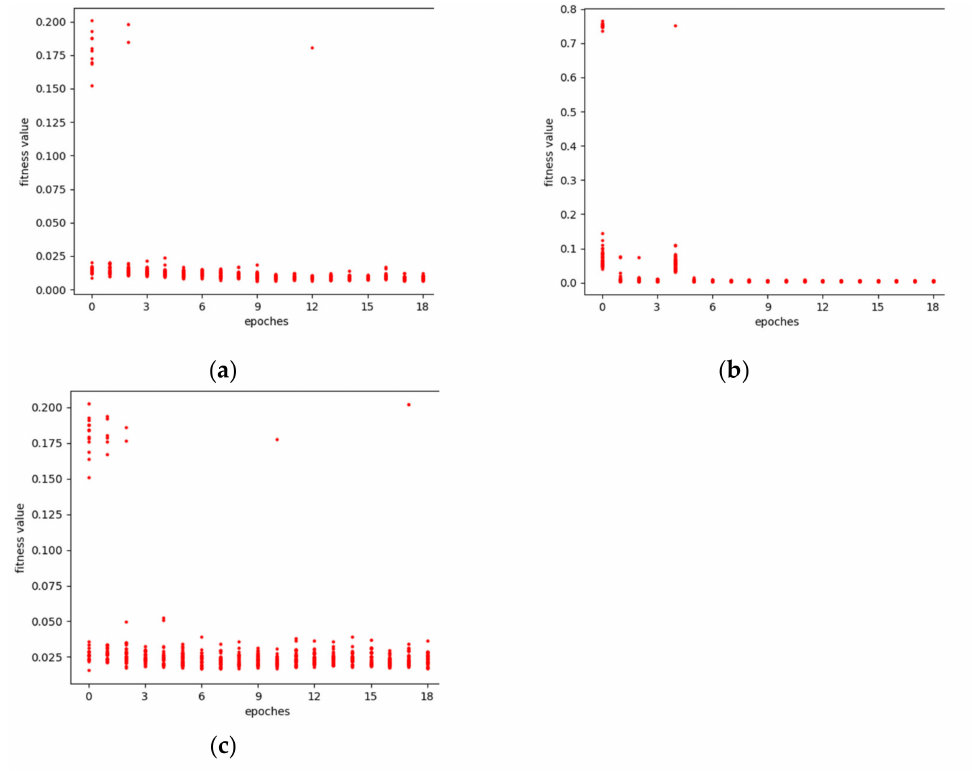
Figure 3. The optimization processes of the GHI model: ( a ) 5 min prediction model optimization process; ( b ) 10 min prediction model optimization process; ( c ) 15 min prediction model optimization